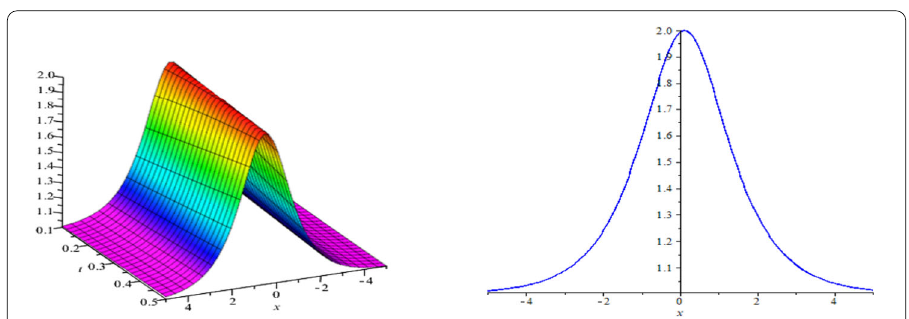
Figure 6 Modulus plot of solution (5.64) which is a bell-shape soliton